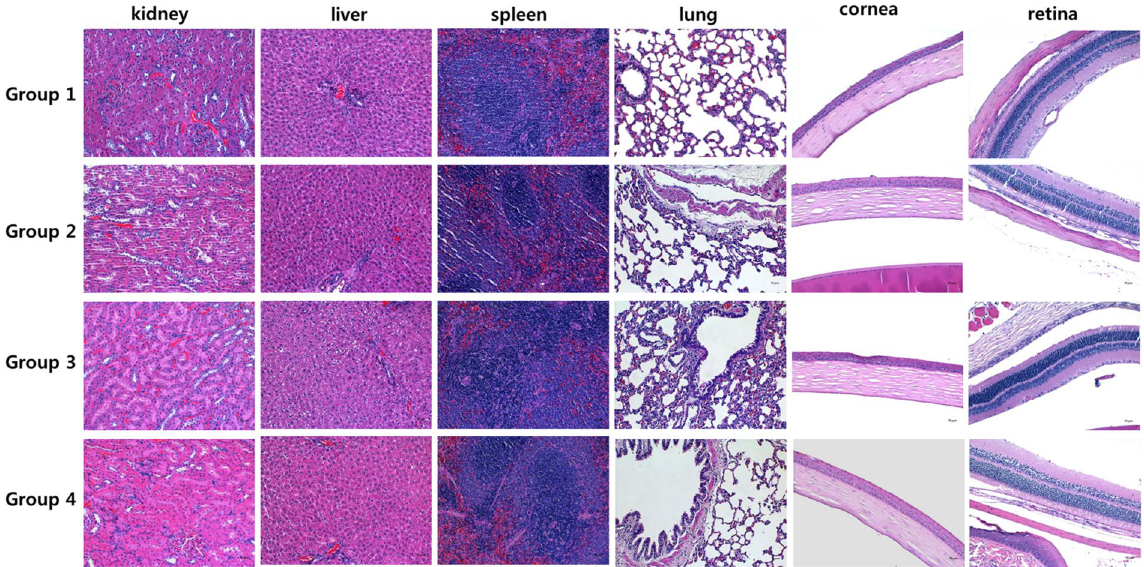
Figure 4. Histopathological findings of organs from the rats treated with SiNPs. Kidney, liver, spleen, lung, and eyeball samples were collected 12 weeks after the SiNP applications. Sections were stained with hematoxylin and eosin ( × 200): No treatment (Group 1, controls); low-dose oral intake (Group 2, 100 mg/kg); high-dose oral intake (Group 3, 1000 mg/kg); topical application (Group 4, 10